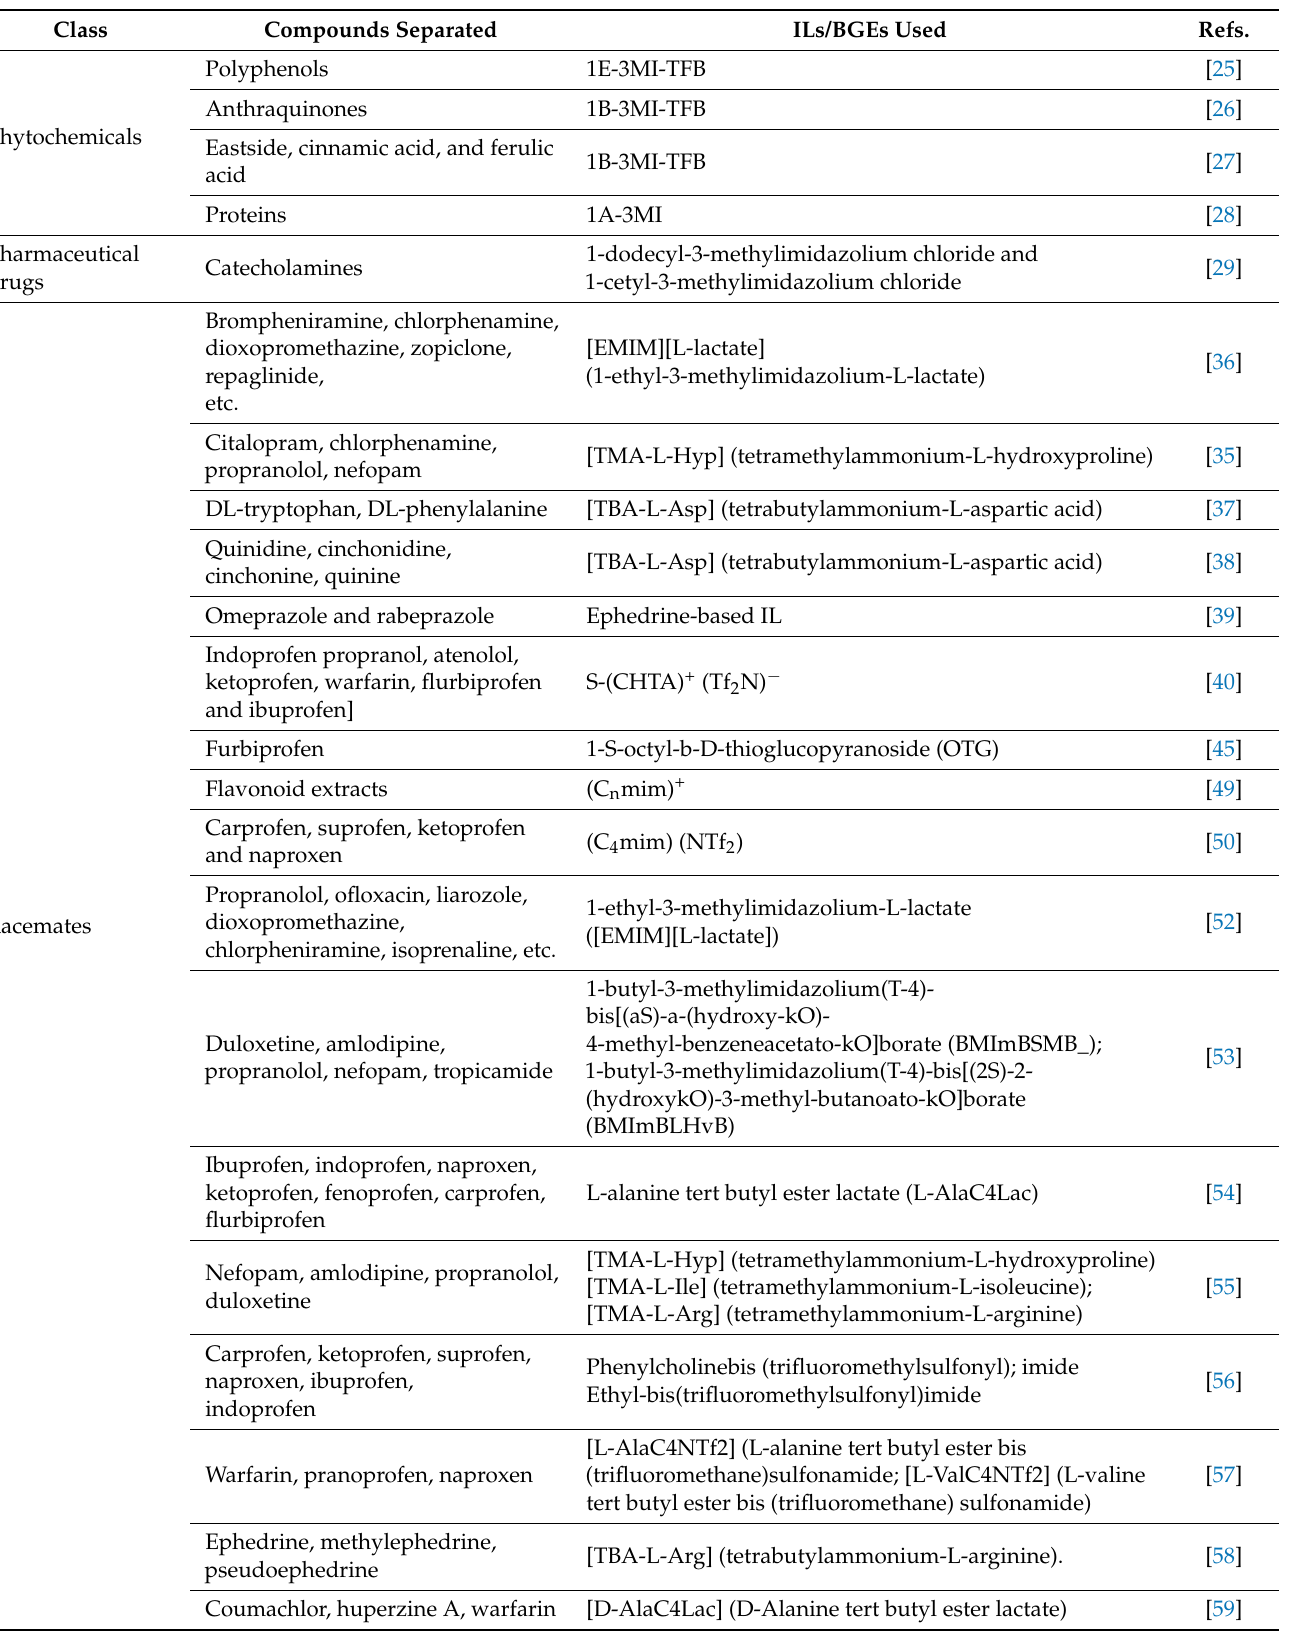
Table 1. Applications of ILs in CE.